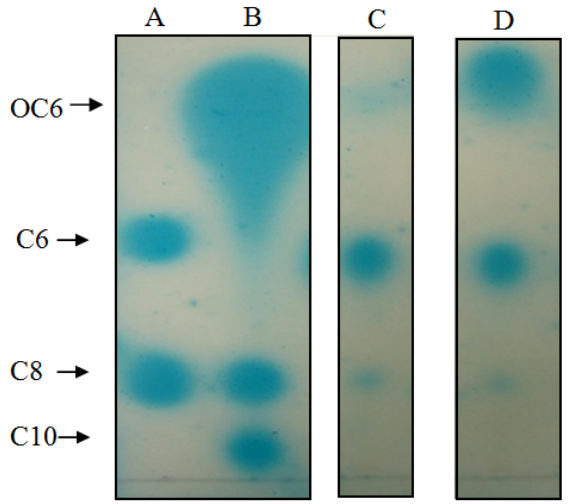
Figure 3. TLC analysis of AHL production by oral K. pneumoniae strains. Arrows indicate the positions of AHL standards run on the same plate. Lane A: C6-HSL (C6) and C8-HSL (C8). Lane B: 3-oxo-C6-HSL (OC6), C8-HSL (C8), and C10-HSL (C10). Lanes C and D: Extracts of spent culture supernatants from T2-1-1 and T2-1-2, respectively.